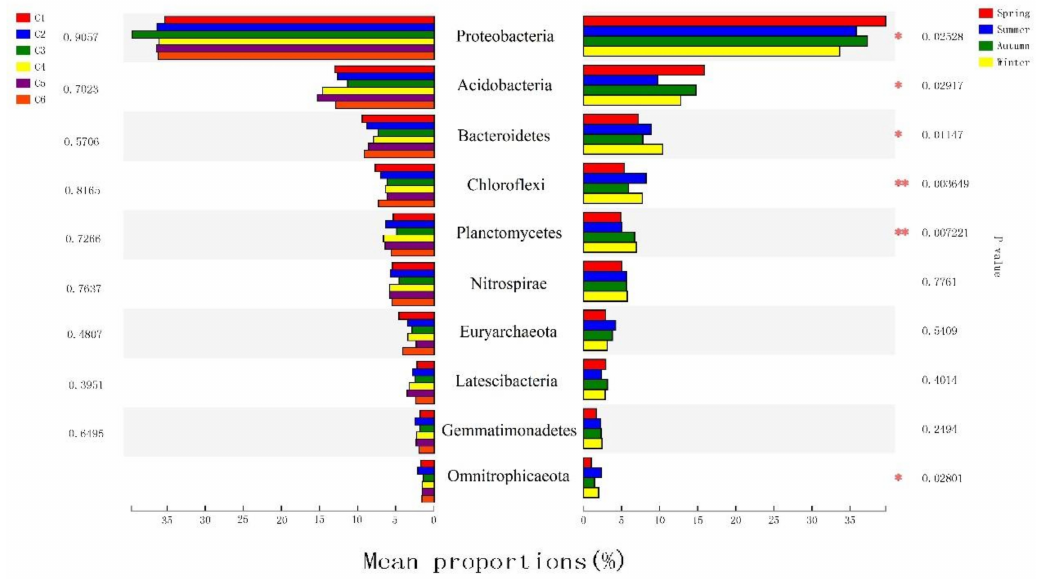
Figure 4. Significantly di ff erent relative abundances among seasons and point groups. One-way analysis of variance (ANOVA) was used to evaluate the importance of comparisons between indicated groups. * P < 0.05, ** P <